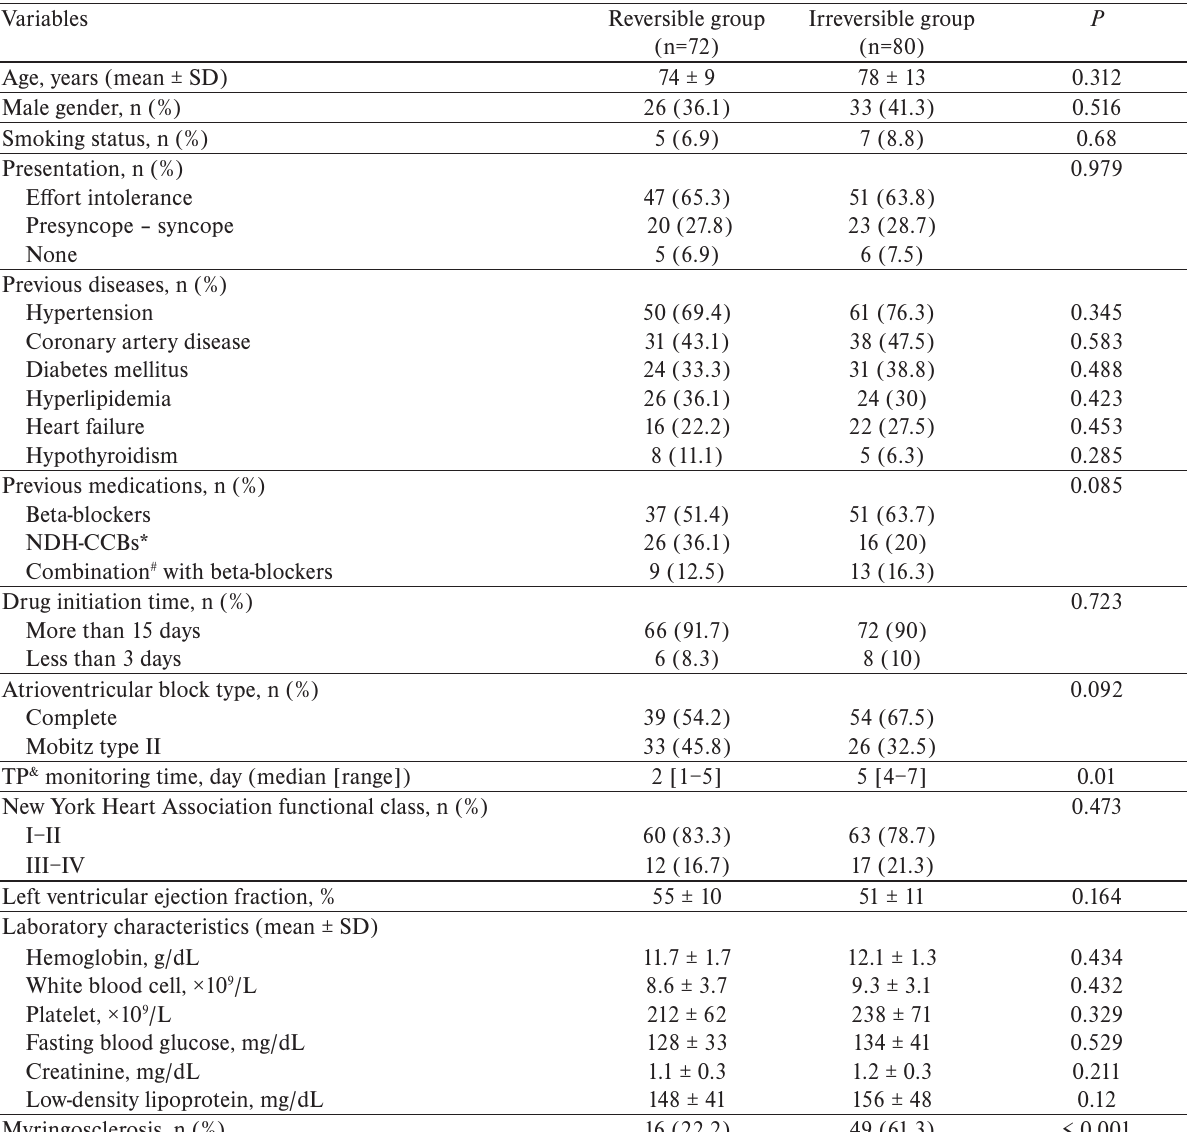
Table 1. Comparison of demographic, clinical, echocardiographic, and laboratory characteristics between groups.